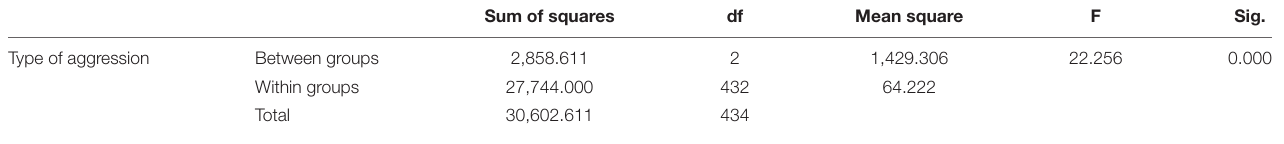
TABLE 1 | Comparison of the mean scores of physical aggression, verbal aggression, and sexual aggression. Sum of squares df Mean square F